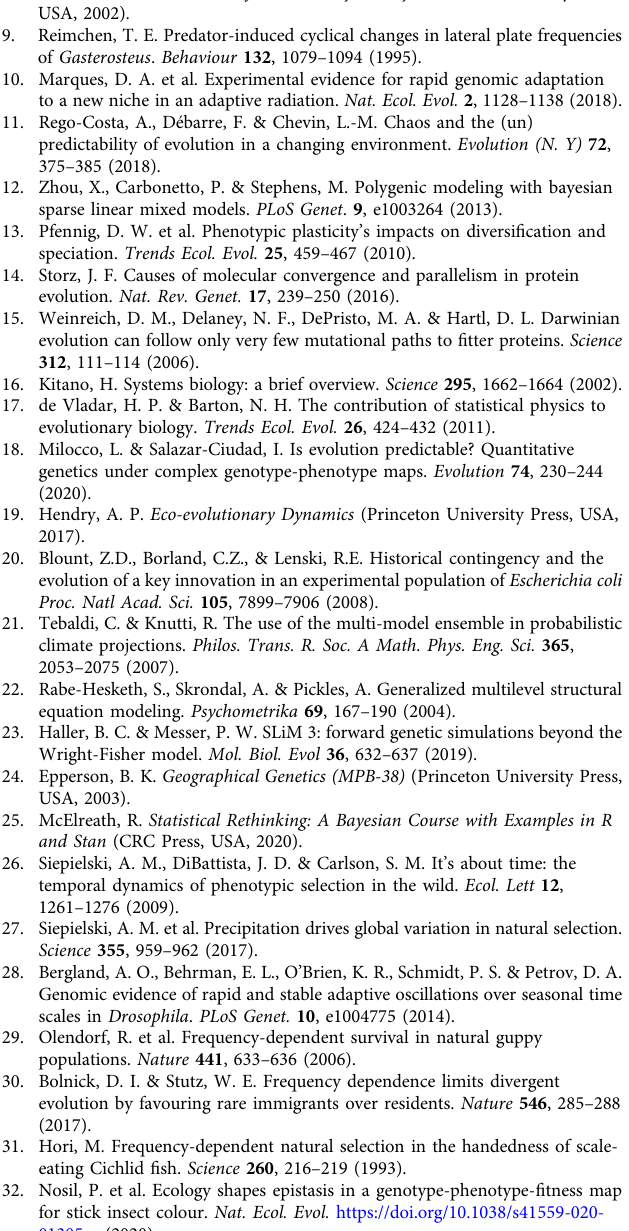
Fig. 3 Hypothetical examples of how variation in different factors can limit the predictability of evolution driven by deterministic natural selection. This fi gure is motivated by empirical systems, but does not depict real data. a Uncertainty in climatic variability can limit the predictability of evolution for traits affected by environment-dependent fl uctuating selection, such as beak size in G. fortis . Here black lines denote observed (left half) or predicted (right half) climatic values, and red lines denote observed (left half) or predicted (right half) trait values. Multiple possible predictions are shown. b Uncertainty in the form of the selection function can limit the predictability of evolution by negative frequency-dependent selection, as is observed for color pattern in T. cristinae stick insects. Possible evolutionary trajectories given three different selection functions (different colored lines) are shown here. c Predictability can also be limited by sensitivity to initial conditions, as occurs on rugged fi tness landscapes with considerable epistasis. Two hypothetical fi tness landscapes with low (top) and high (bottom) epistasis, and thus sensitivity to initial conditions, are shown (left side; the axes represent genotypes for different loci). Hypothetical evolutionary trajectories from different starting conditions are shown on the right (colored lines). High epistasis promotes different outcomes dependent on initial conditions. Finch and stick insect drawings courtesy of